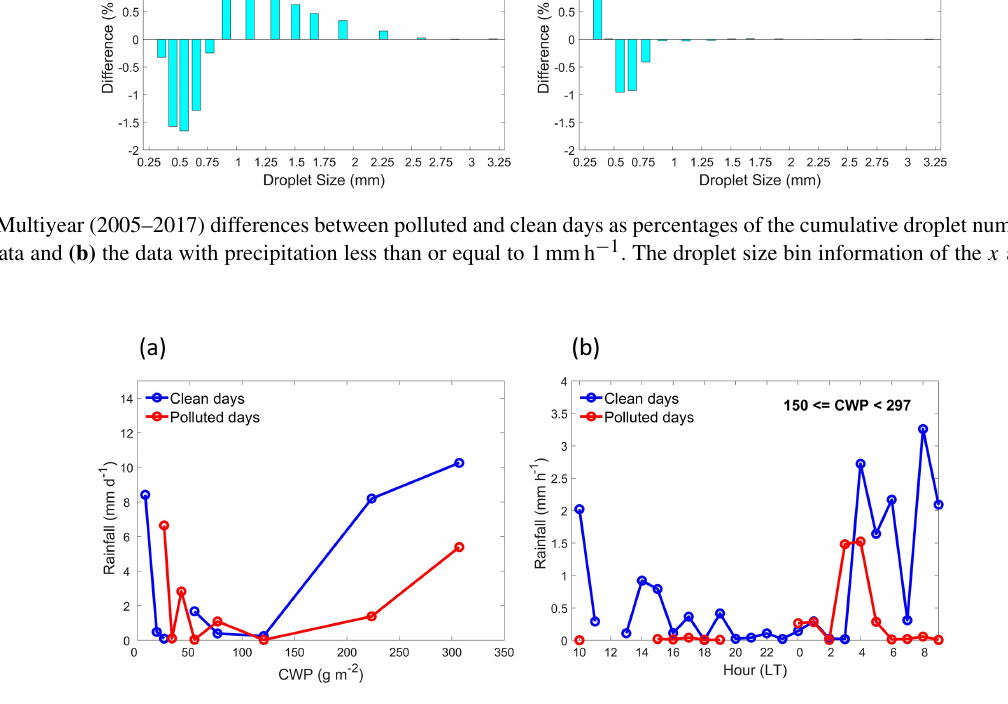
Figure 12. Multiyear (2005–2017) (a) mean rainfall in different CWP groups calculated for clean and polluted days, and (b) average hourly rainfall rate calculated for clean and polluted days according to CWP group 9 (150 ≤ CWP < 297) only. Rainfall analyses were performed from 10:00, and the PM 2 . 5 data were averaged from 10:00 to 14:00 as daily PM 2 . 5